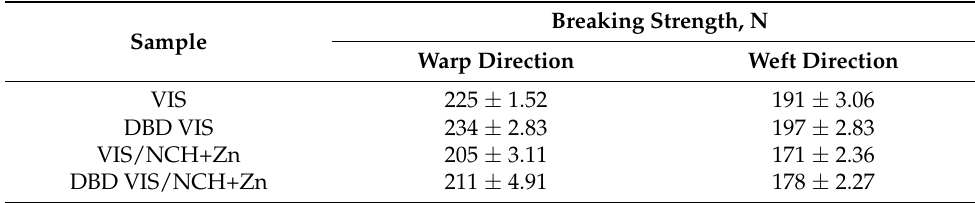
Table 2. Breaking strength of unmodified and DBD-modified viscose fabrics before and after func- tionalization with NCH+Zn. Part of results previously published in